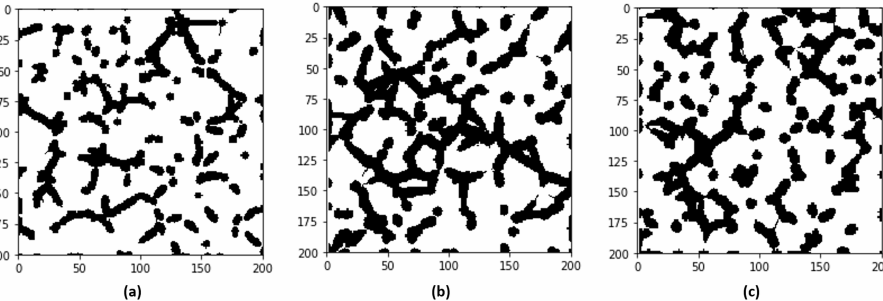
Figure 3. Cross-sections of the modeled GDL through the main plane, where ( a ) is at the input face, ( b ) is at the middle of the plane and ( c ) is at the output